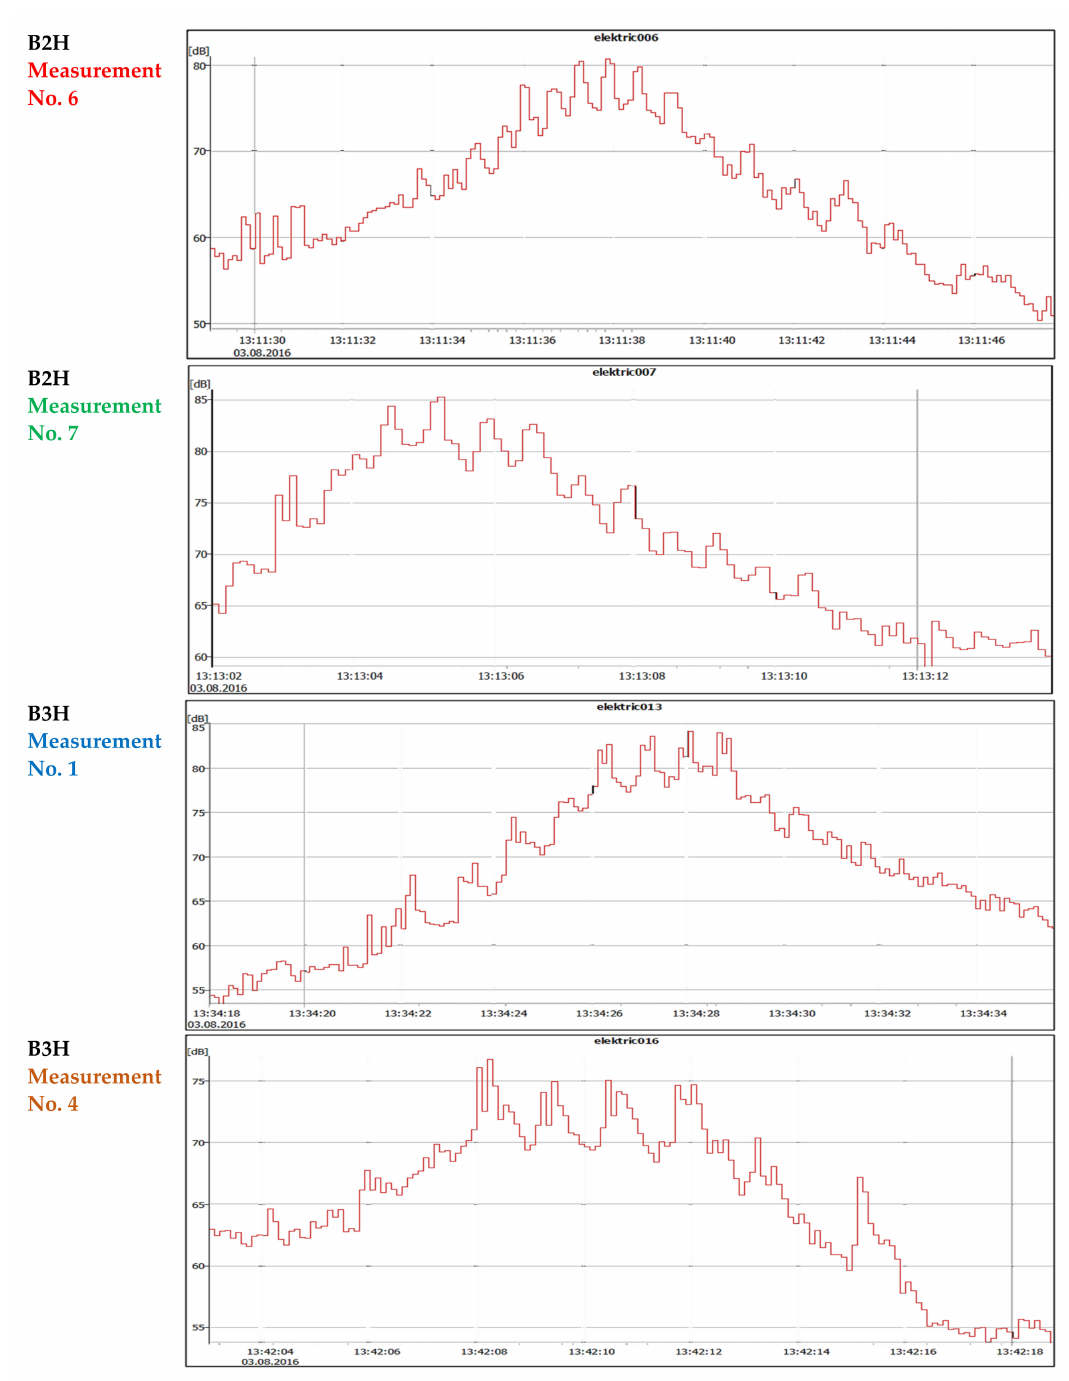
Figure 16. Time history of noise level values L Aeq of selected